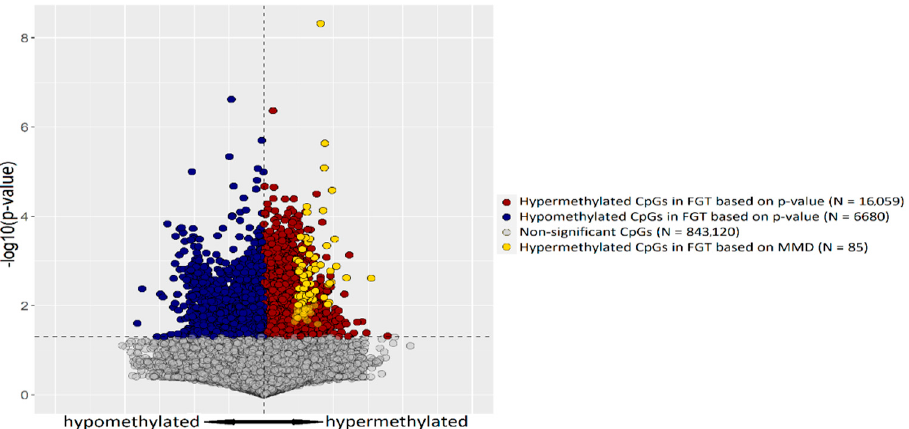
Figure 2. Volcano plot of DNA methylation data derived from microarray analysis of FGT ( n = 4) and SGT ( n = 4) samples. Red and blue dots represent hyper- and hypomethylated CpG sites in FGTs, respectively, gray dots represent nonsignificant CpG sites. In all, 85 CpGs hypermethylated in FGT, selected based on MMD, are shown as yellow dots in the background of all significantly hypermethylated